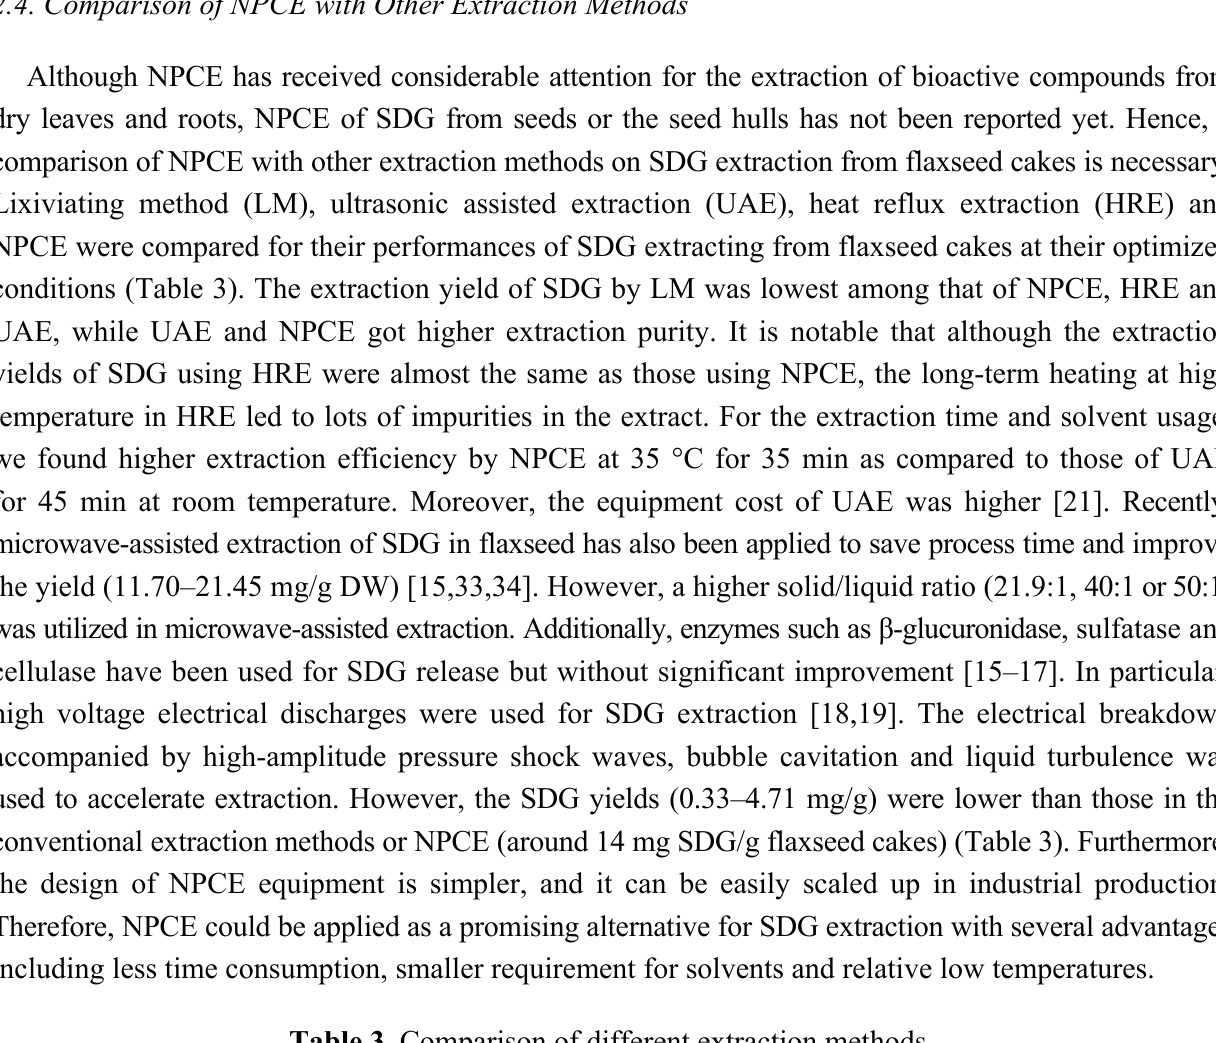
Table 3. Comparison of different extraction